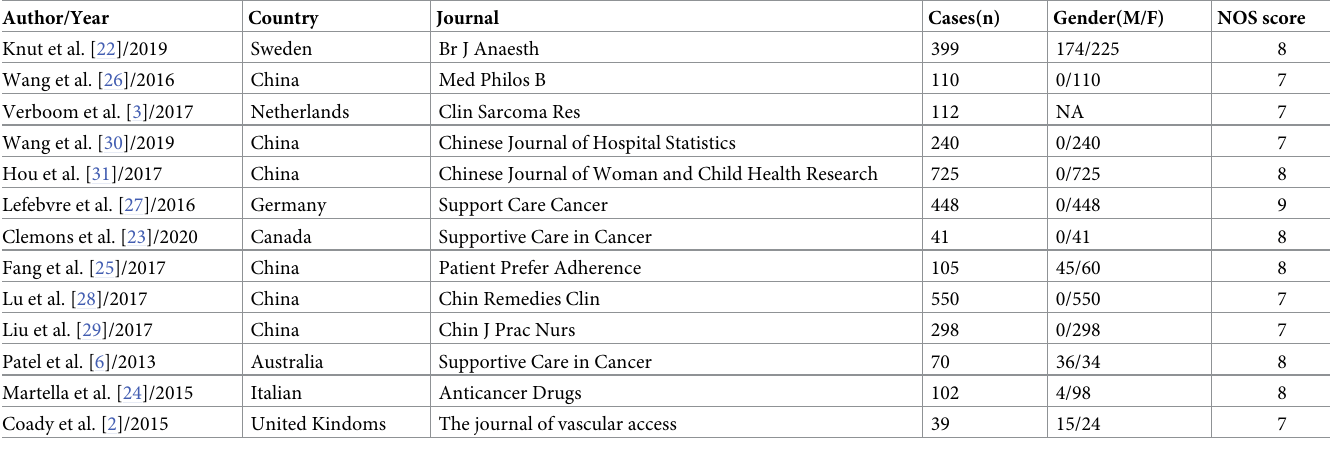
Table 1. Characteristics of 13 studies included in the